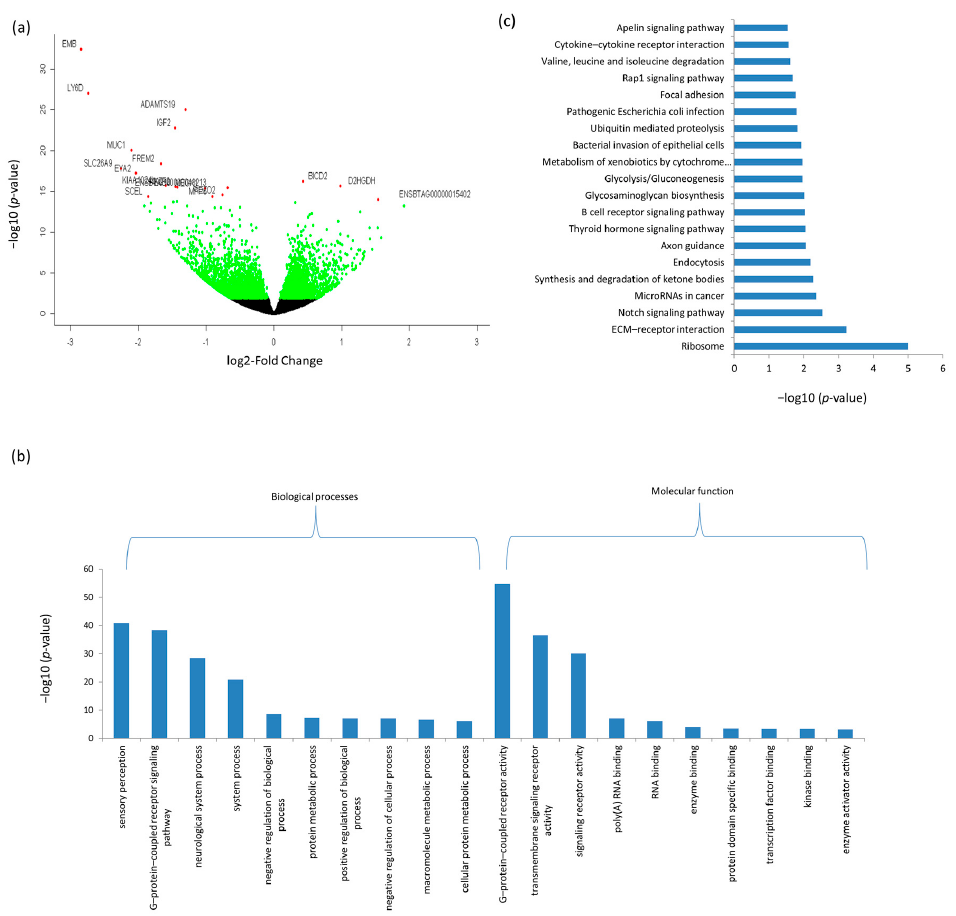
Figure 1. Differentially expressed genes and their enriched gene ontology (GO) terms and Kyoto Encyclopedia of Genes and Genomes (KEGG) pathways in rumen tissues. ( a ) Differentially expressed messenger RNAs (mRNAs); ( b ) top GO terms and ( c ) KEGG pathways. ECM: Extracellular matrix. A total of 459 biological process (BP) and 52 molecular function (MF) GO terms were significantly enriched for rumen DE mRNAs and the most enriched terms were sensory perception